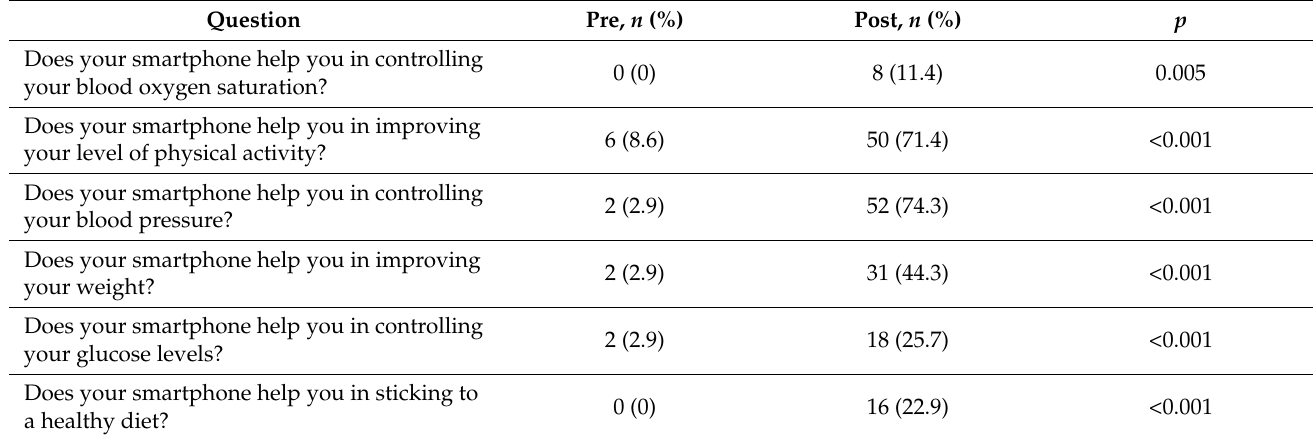
Table 4. Wilcoxon signed-rank test for the pre–post questionnaire ( n = 70).